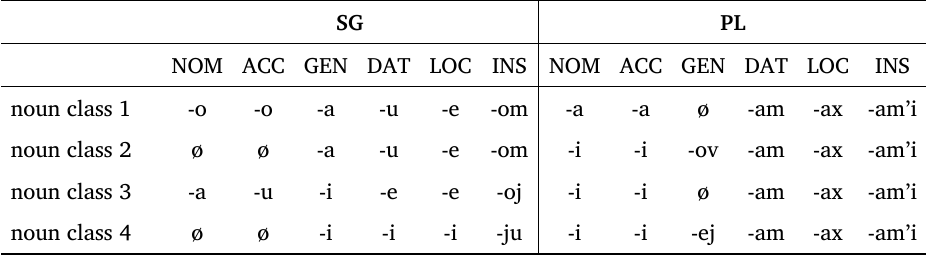
Table 1: Russian nominal inflection paradigm (phonological transcription). Nouns fall into one of 4 inflection classes (rows) which show different pat- terns of inflection; nouns are inflected for number (SG=singular, PL=plural) and case (NOM=nominative, ACC=accusative, GEN=genitive, DAT=dative, LOC=locative, INS=instrumental) SG PL NOM ACC GEN DAT LOC INS NOM ACC GEN DAT